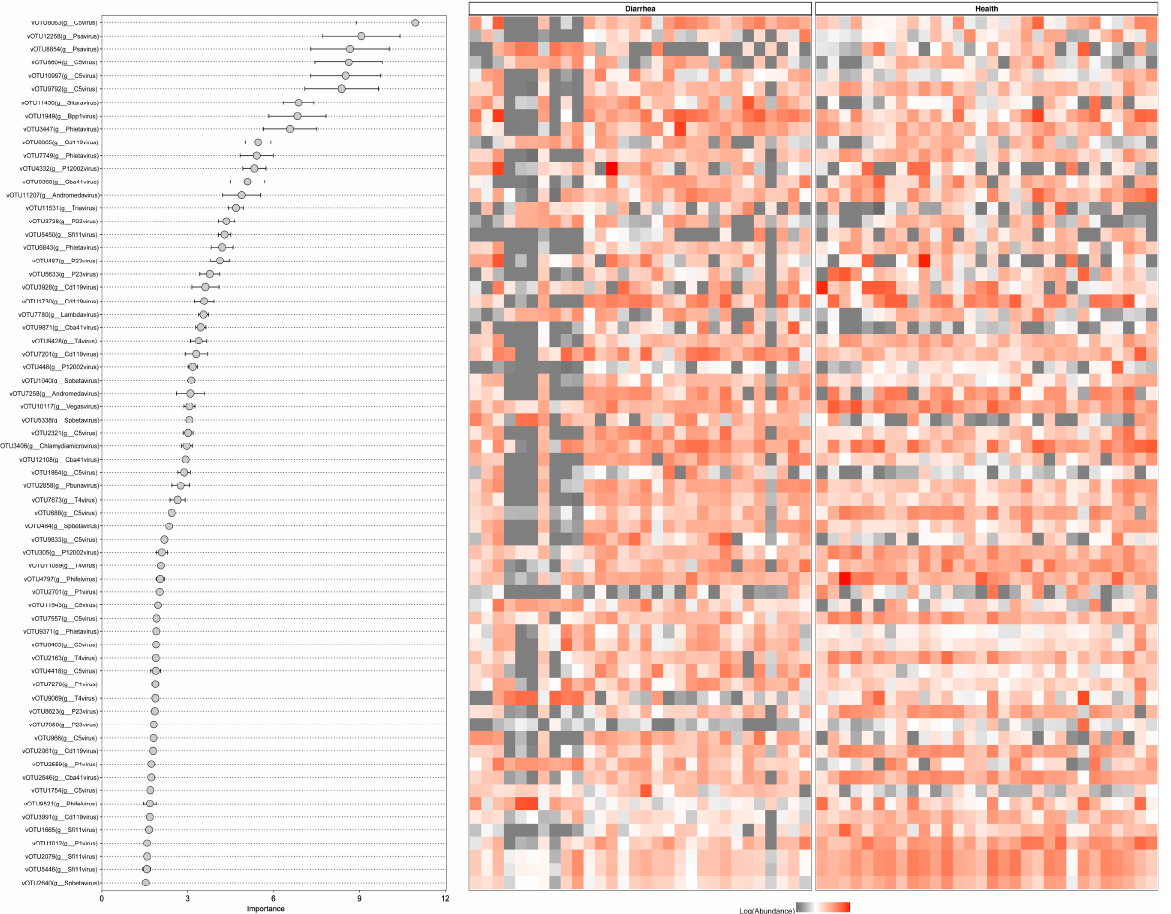
Figure 5. Random forest classification model identifying specific signature discriminating between healthy and diarrheal neonatal piglets. The left panel shows the top 30 viruses ordered by importance of contribution to the model. The right heatmap shows the scaled abundance distribution in each sample.